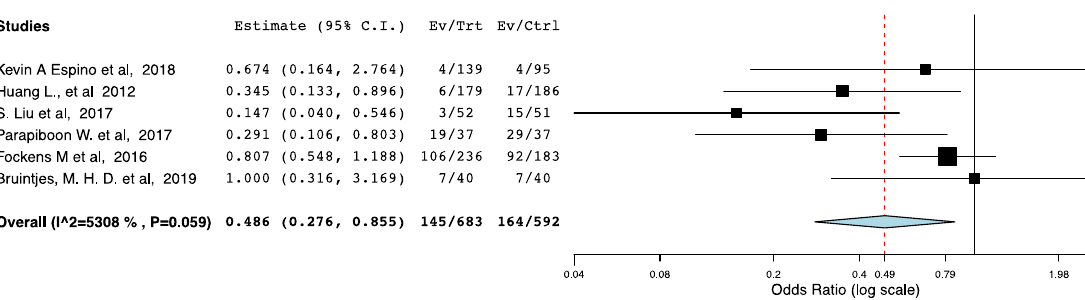
Figure 5. Forest plot: urological complications (ERAS vs. traditional perioperative care).